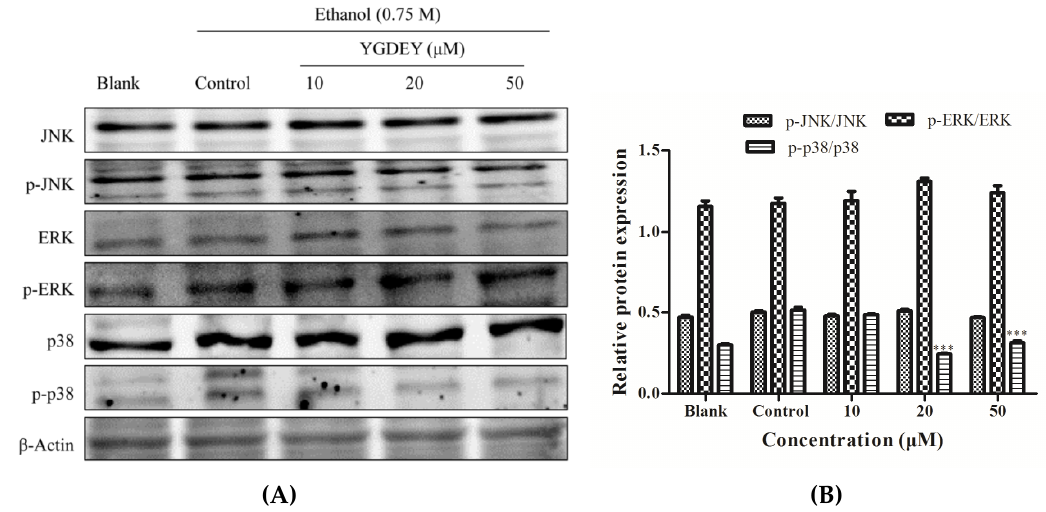
Figure 7. ( A ) Effect of YGDEY on the MAPK signaling pathway in HepG2 cells. Cells were pretreated with YGDEY (10, 20, and 50 µ M) for 24 h before induction by 0.75 M ethanol for 2 h. β -Actin was used as an internal control. ( B ) Relative protein expression was normalized. Data are shown as means ± SD ( n = 3). *** compared with the control group, p < 0.001.